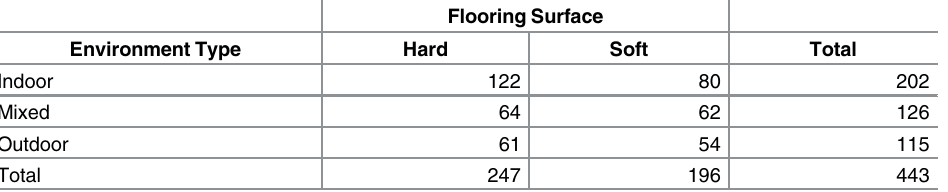
Table 11. Environment type (indoor, mixed, outdoor) frequency by 100% substrate coverage of hard (concrete and stone aggregate) or soft (grass, sand, and rubber padding)